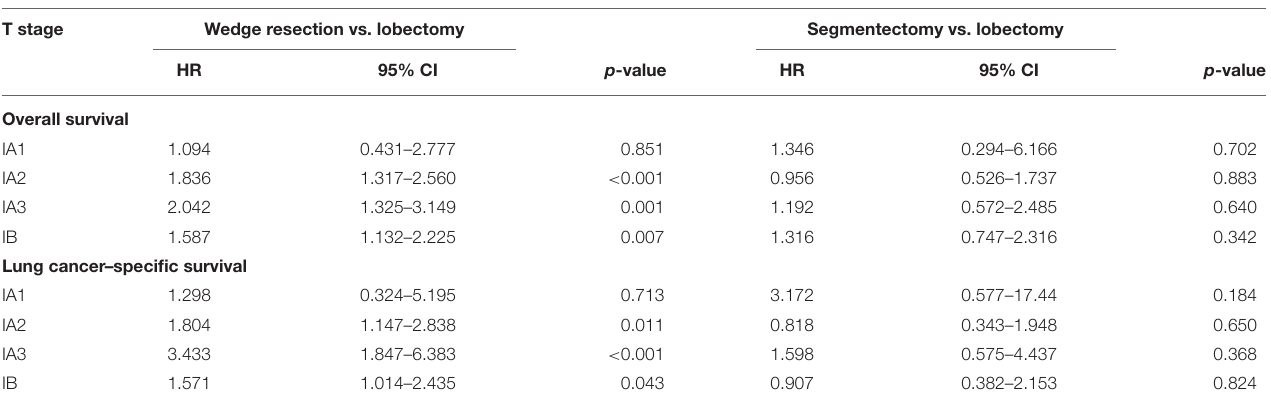
TABLE 4 | Stratified univariate Cox regression analyses in matched cohort. T stage Wedge resection vs. lobectomy Segmentectomy vs. lobectomy HR 95% CI p -value p